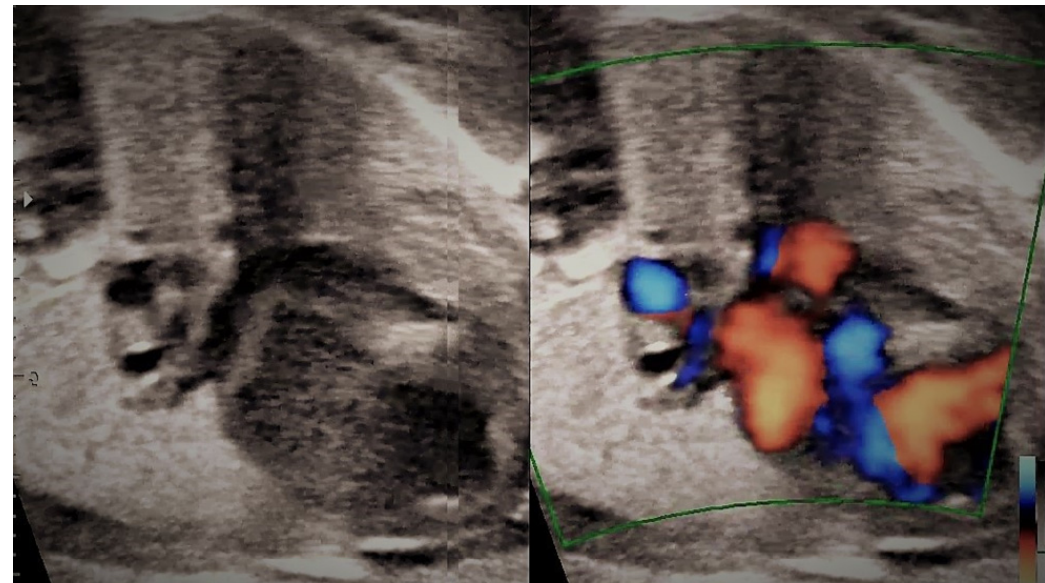
Figure 15. The same case as above; retro atrial vessel behind the left atrium. Figure 16. The same case as above; retro atrial vessel behind the left atrium.